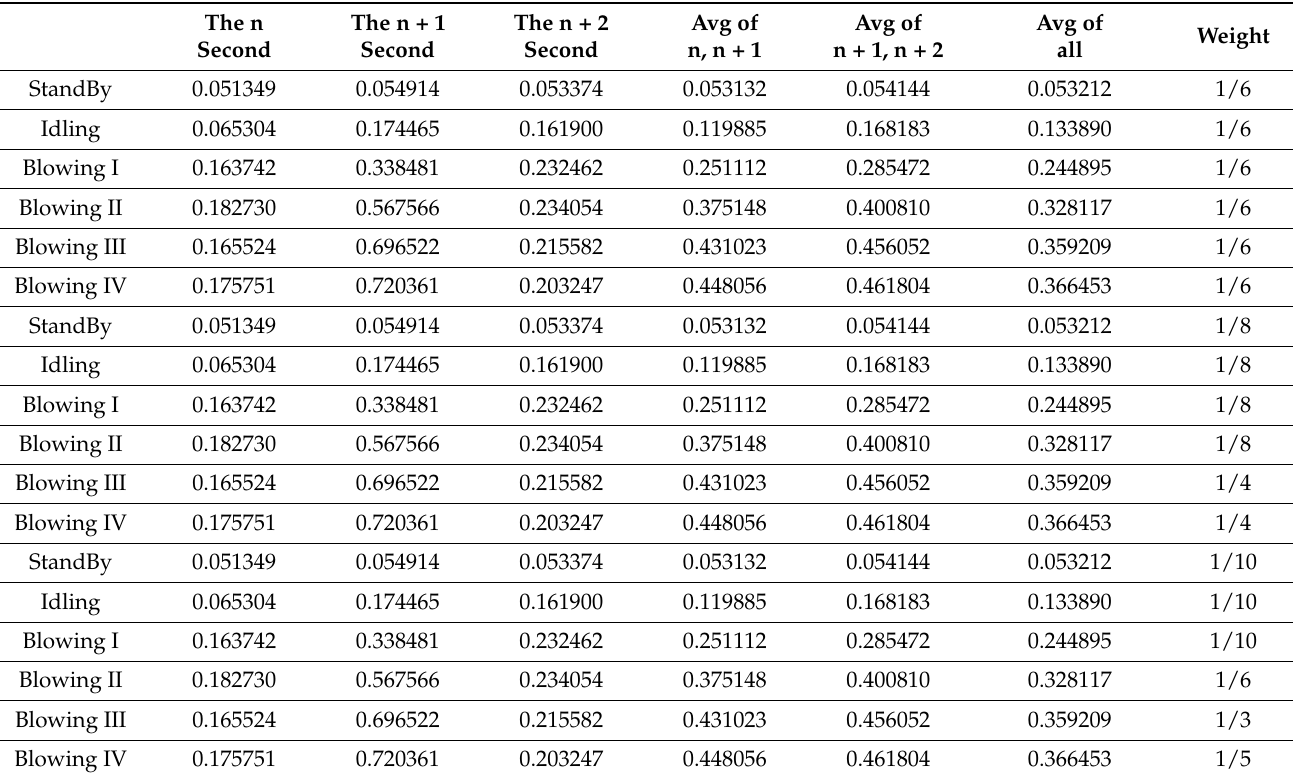
Table 3. Adaboost weight